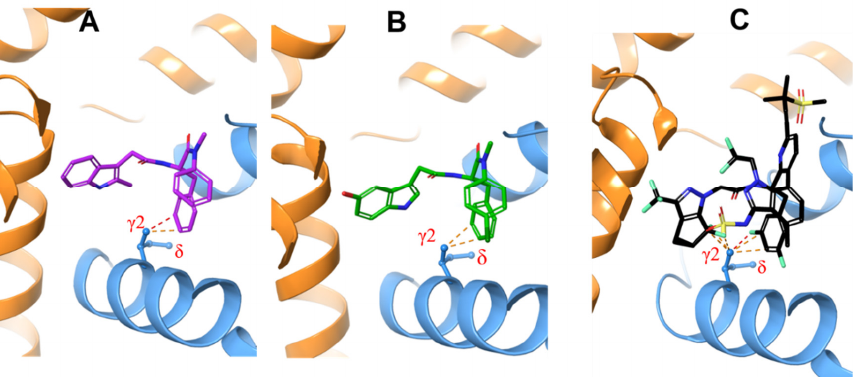
Figure 4. PF74 ( A ) in purple, ZW-1261 ( B ) in green, and GS-6207 ( C ) in black are inserted into the MD structure of the apo M66I CA mutant pocket by superimposing the protein in the holo M66I with that of the apo M66I. The atomic clashes are illustrated by yellow dashed lines.